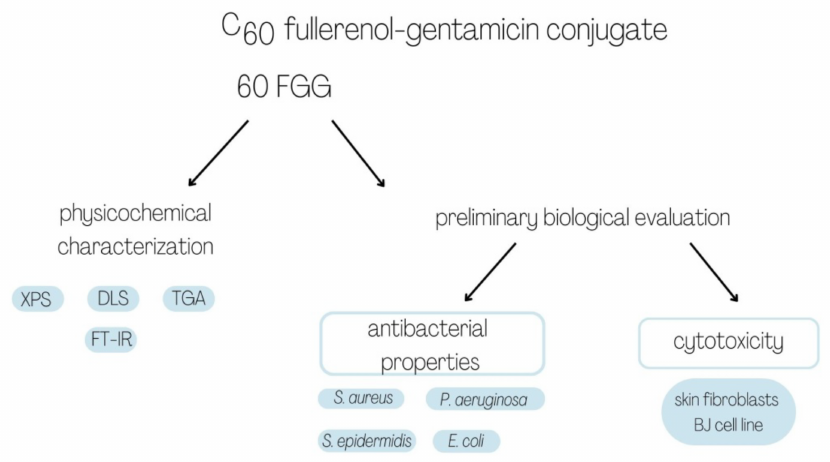
Figure 6. Schematic diagram presenting the experiments performed within this